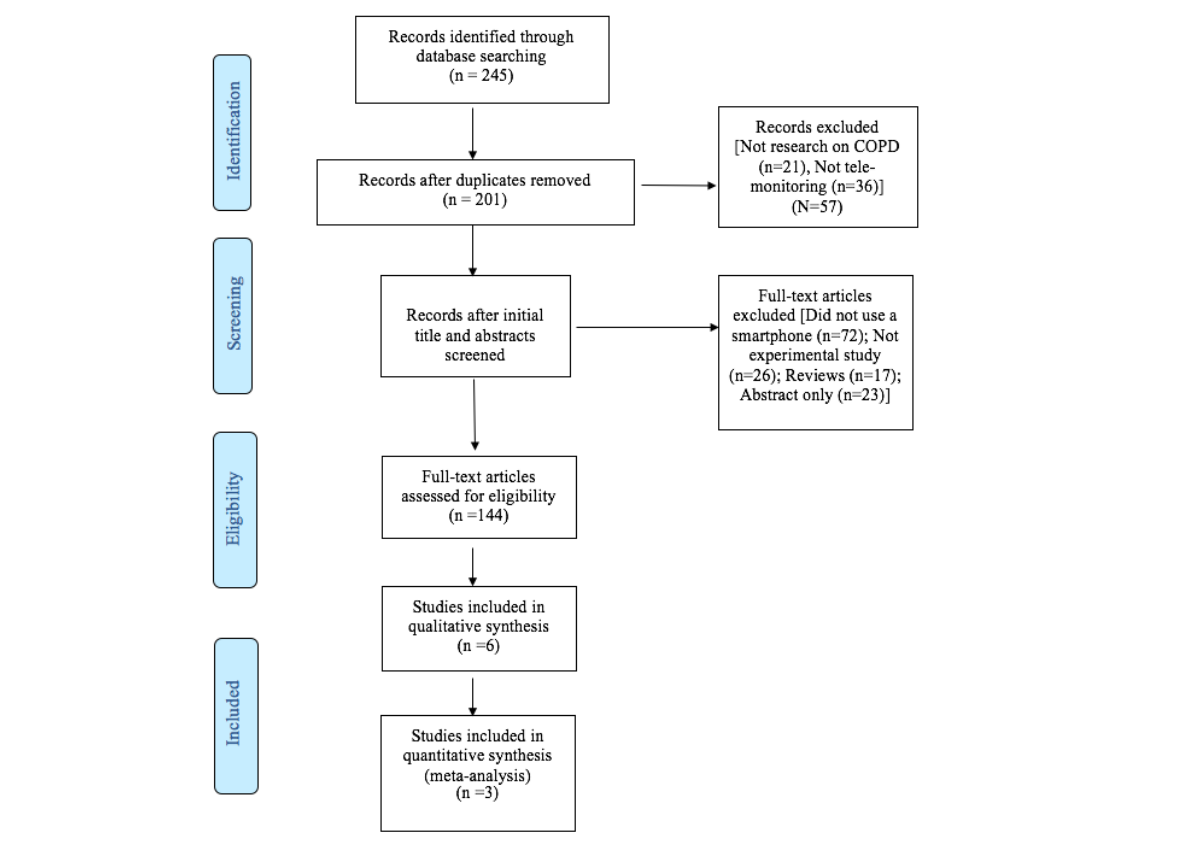
Figure 1. Preferred Reporting Items for Systematic Reviews and Meta-Analyses flow diagram of search results and study selection. COPD: chronic obstructive pulmonary